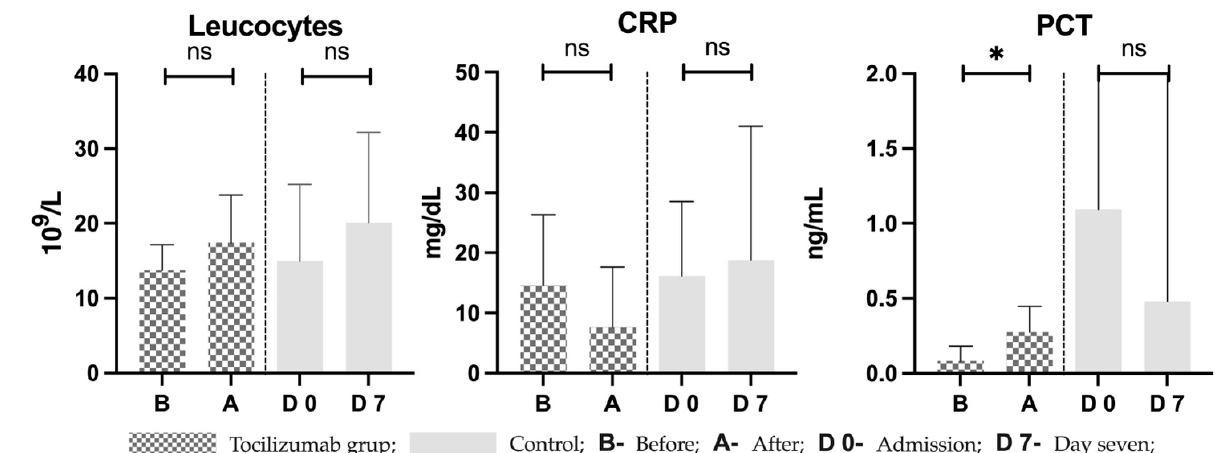
Figure 4. Laboratory parameters related to sepsis in the treated group and controls. B—right before receiving treatment with tocilizumab; A—seven days after treatment; D 0—on admission in control group; D 7—seven days after admission in controls; CRP = C reactive protein; PCT = procalcitonin; * = statistically significant; ns = statistically non-significant.